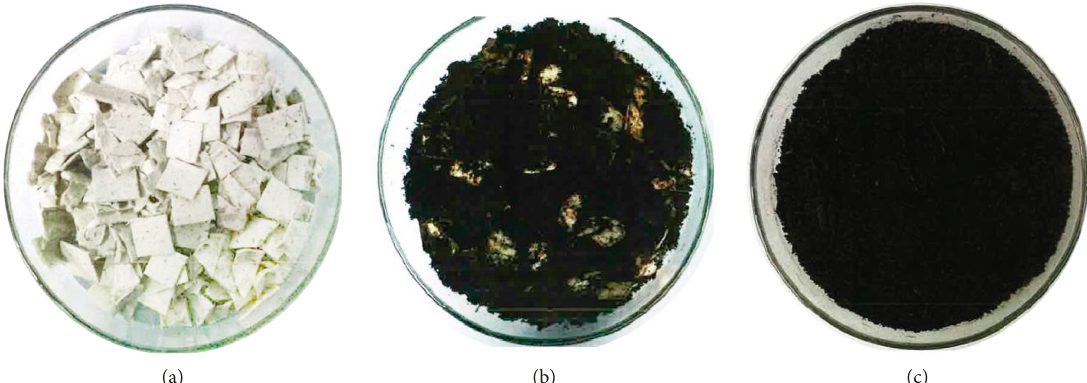
Figure 8: Change of sample appearance with time ((a): sample before the test; (b): sample and composts before the test; (c): sample and compost after 45 days test).